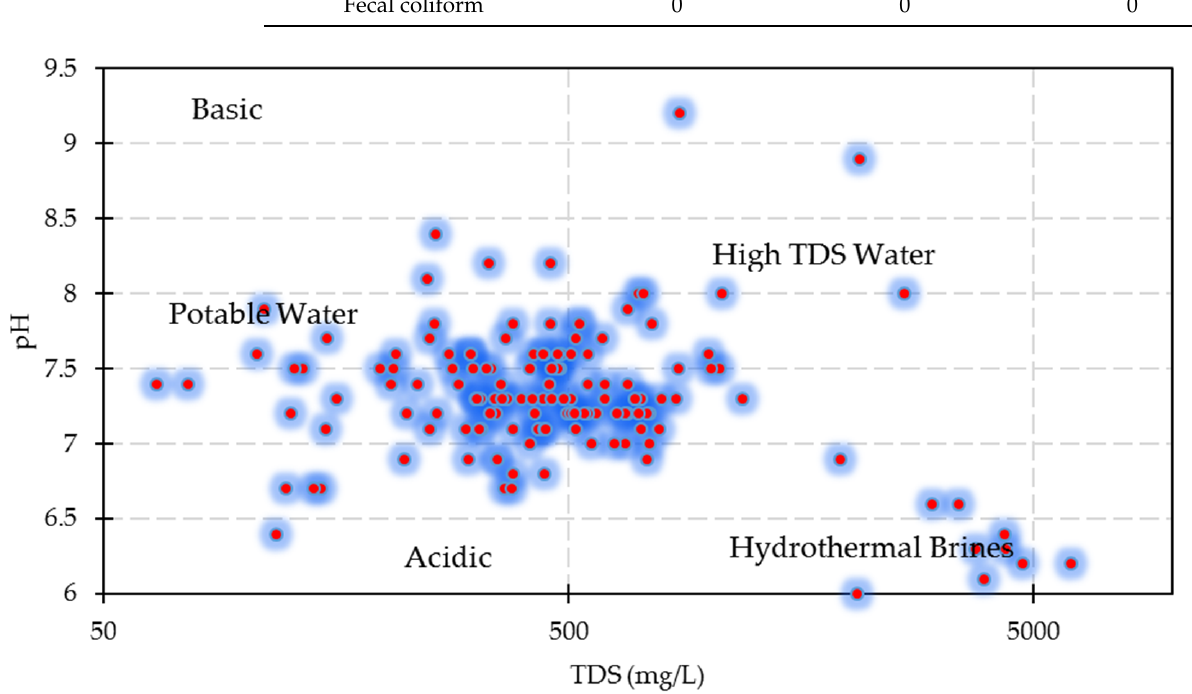
Figure 4. Relationship between TDS and pH in analyzed water samples. Most of thermal springs within the study area were contaminated by trace elements such as arsenic, total iron, copper, manganese, zinc, and barium; the concentrations of these trace elements were typically higher than the acceptable concentrations for drinking water (average values: As = 4.78 µ g/L, Ba = 1.70 mg/L, Cu = 1.70 mg/L, Mn = 0.42 mg/L, Fe = 0.37 mg/L, and Zn = 0.31 mg/L). However, high trace element concentrations did not appear in all of the water sources; for example, arsenic was only detected in about 9% of